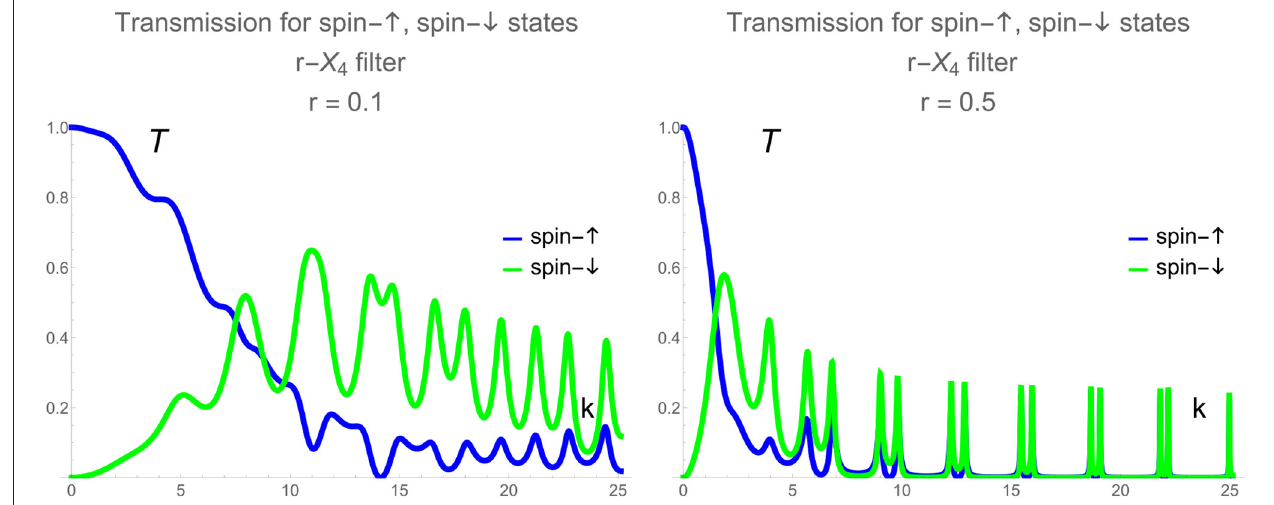
FIGURE 7 | Transmission r